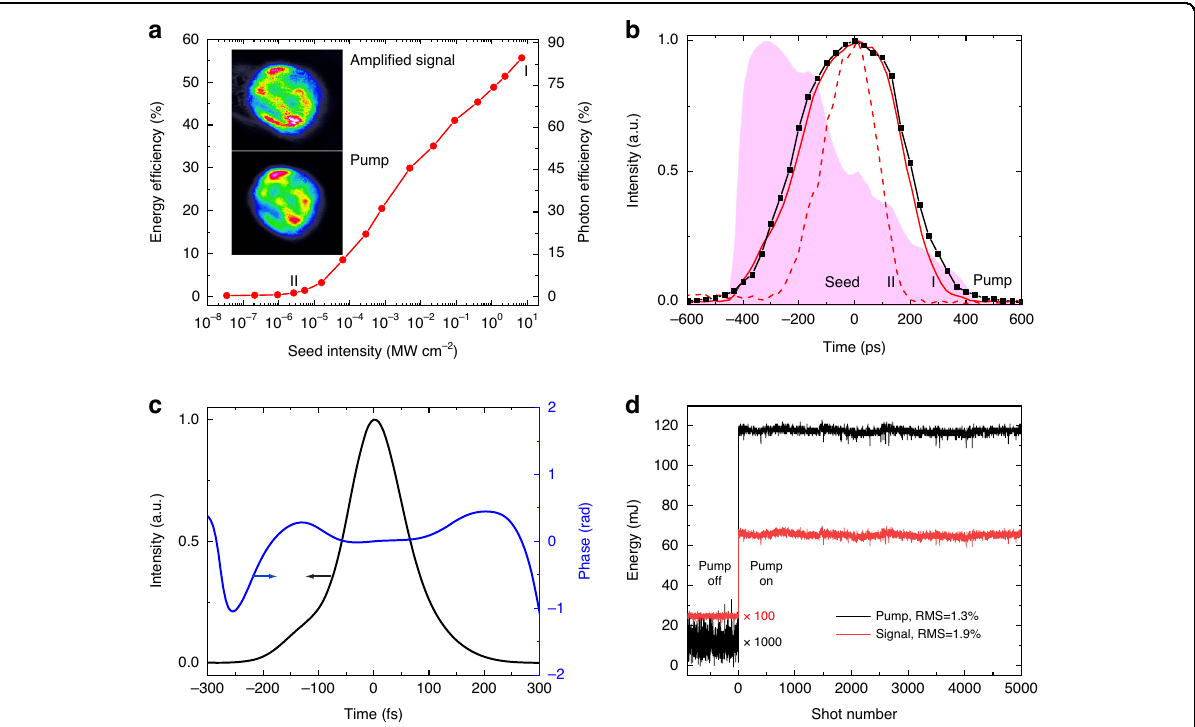
Fig. 3 Highly ef fi cient signal ampli fi cation. a Pump-to-signal ef fi ciency and pump depletion versus seed intensity at a pump intensity of ~3 GW cm − 2 . Inset, beam pro fi les of the ampli fi ed signal and pump. b Pulse pro fi les of the pump (black), ampli fi ed signal at seed intensities of 7 MW cm − 2 (red solid, point I marked in a ) and 2.5 W cm − 2 (red dashed, point II marked in a ). The shaded area shows the chirped-pulse pro fi le (spectrum) of the signal seed. The chirped-pulse of the signal is linearly mapped by its spectrum with a coef fi cient of 40 ps nm ‒ 1 . c Intensity (black) and phase (blue) of the compressed signal pulse (GRENOUILLE 8-50-USB, Swamp Optics). d Five-thousand shots of pump energy (black), and ampli fi ed signal energy (red). The measurements are performed by two identical energy meters and begin slightly before the pump